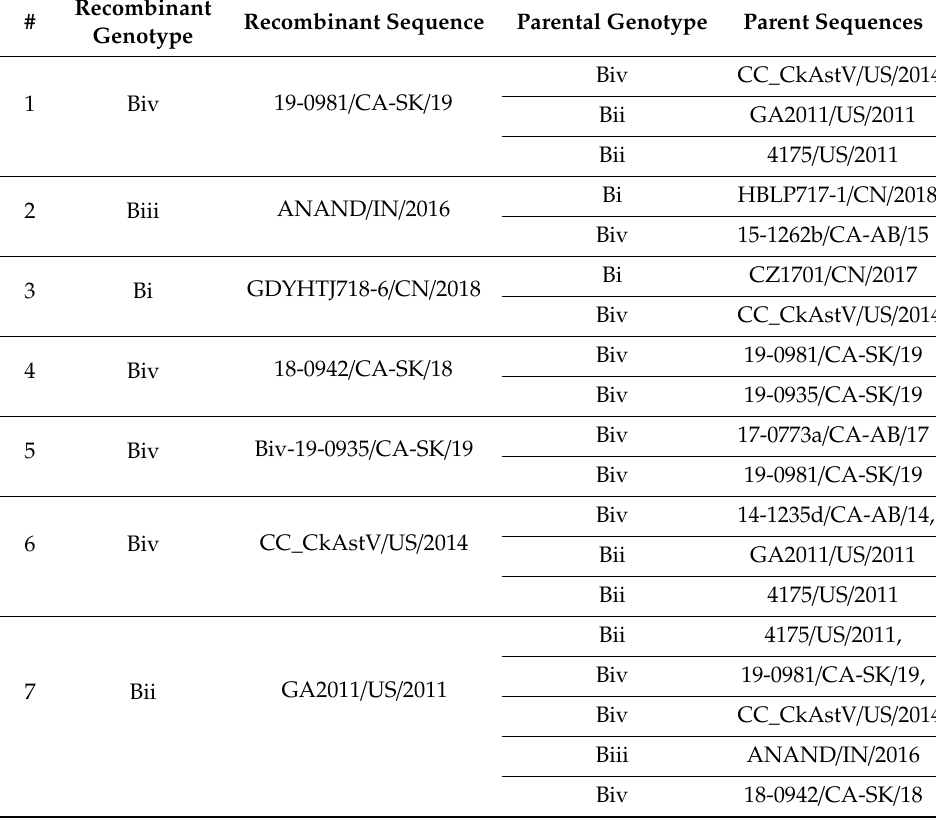
Table 4. CAstV recombinant sequences and parents / parent-like sequences detected by 6 recombination methods in RDP5, ML phylogenetic trees, and Bootscan analysis in SimPlot